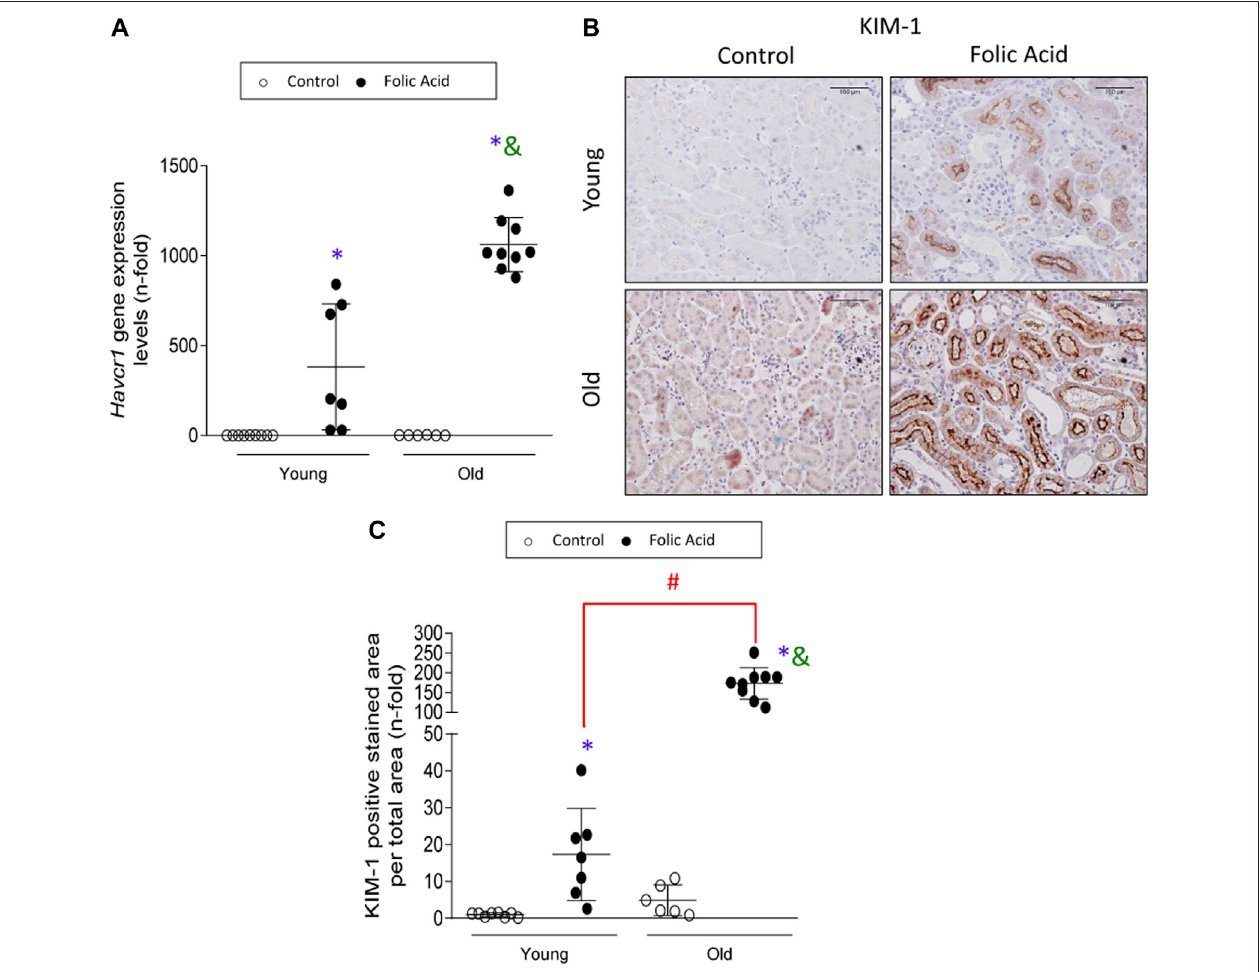
FIGURE2| The damagebiomarker KIM-1isoverexpressed ininjured tubules ofoldmice. Folic Acid(FA; 125 mg/kg) wasinjected in3-months-old (Young)and 1- year-old (Old) C57BL/6 mice and kidneys were studied after 48 h. (A) Total mRNA was isolated from frozen sections of whole kidneys and qRT-PCR was performed to determine gene expression levels of Havcr-1 . (B) Representative microphotographs of KIM-1 expression levels evaluated by immunohistochemistry and (C) its quanti fi cationofstainedareapertotalarea.Scalebars (cid:2) 100 μ m.Dataareshownasn-foldandexpressedasmean ± SDof n (cid:2) 6 – 9animalspergroup.* p < 0.05vs. control young mice, # p < 0.05 vs. FA-injected young mice, & p < 0.05 vs. control old mice. The non-parametric Kruskal-Wallis statistical test was